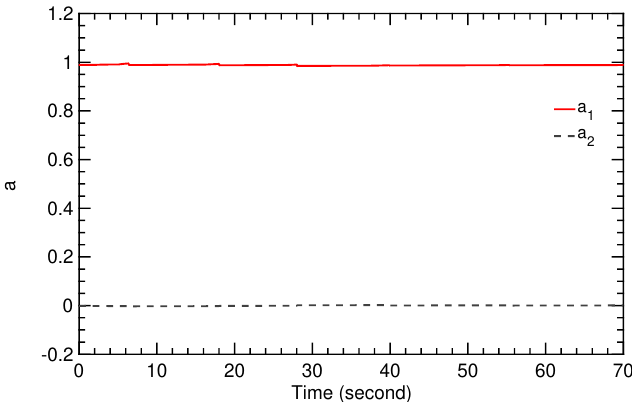
Figure 18. Time history of TF coefficients a 1 and a 2